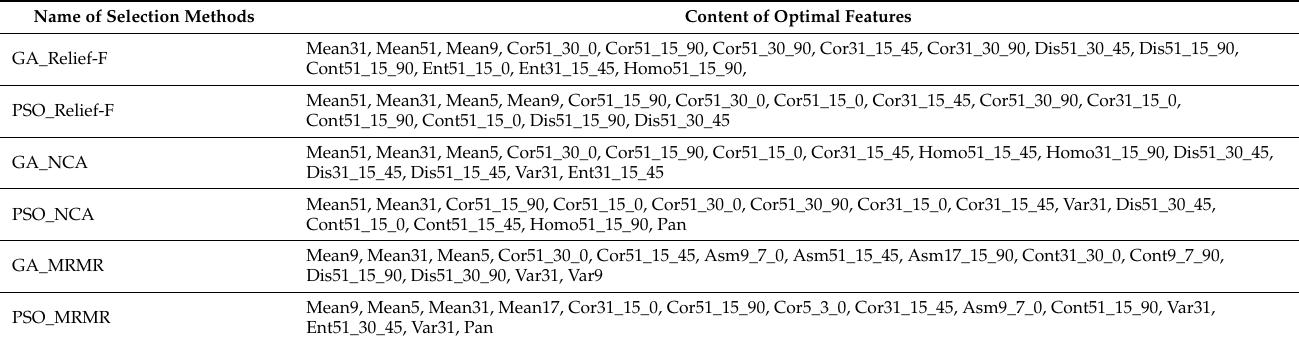
Table A10. Filter-based methods from wrapper-based results identified the last 14 optimal